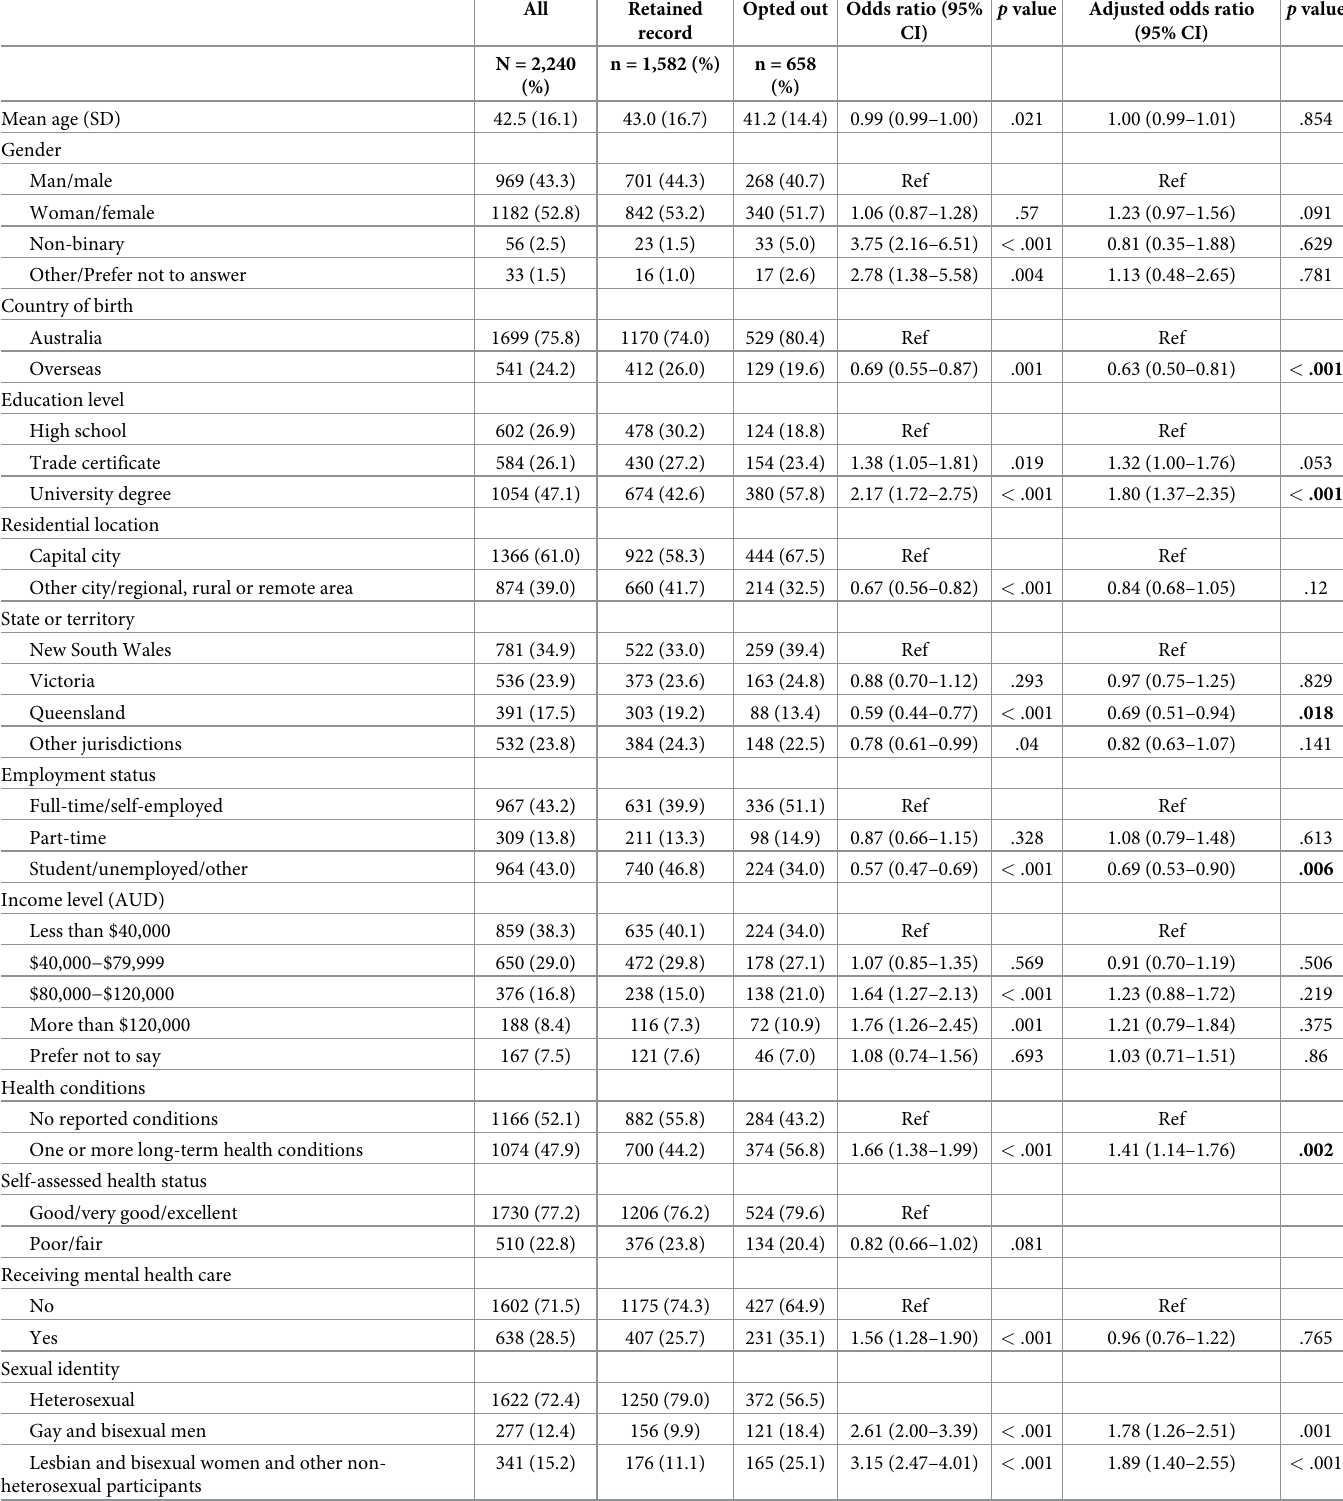
Table 2. Factors associated with opting out of or deleting My Health Record among survey participants (N =